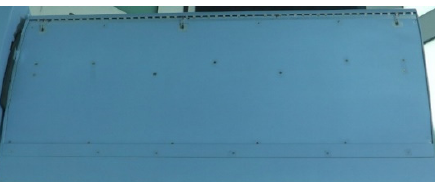
Figure 3. DCFJ312 airfoil model.